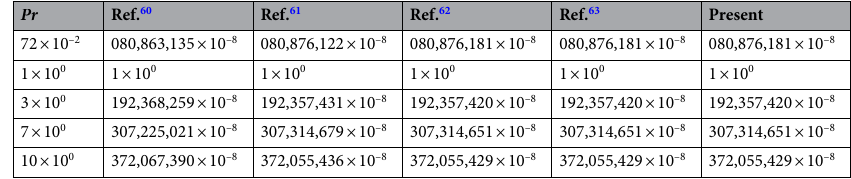
′ ( 0 ) for variation in Pr , and taking Q = 0 , M = 0 , φ = 0 , (cid:31) = 0 , Nr = 0 ,